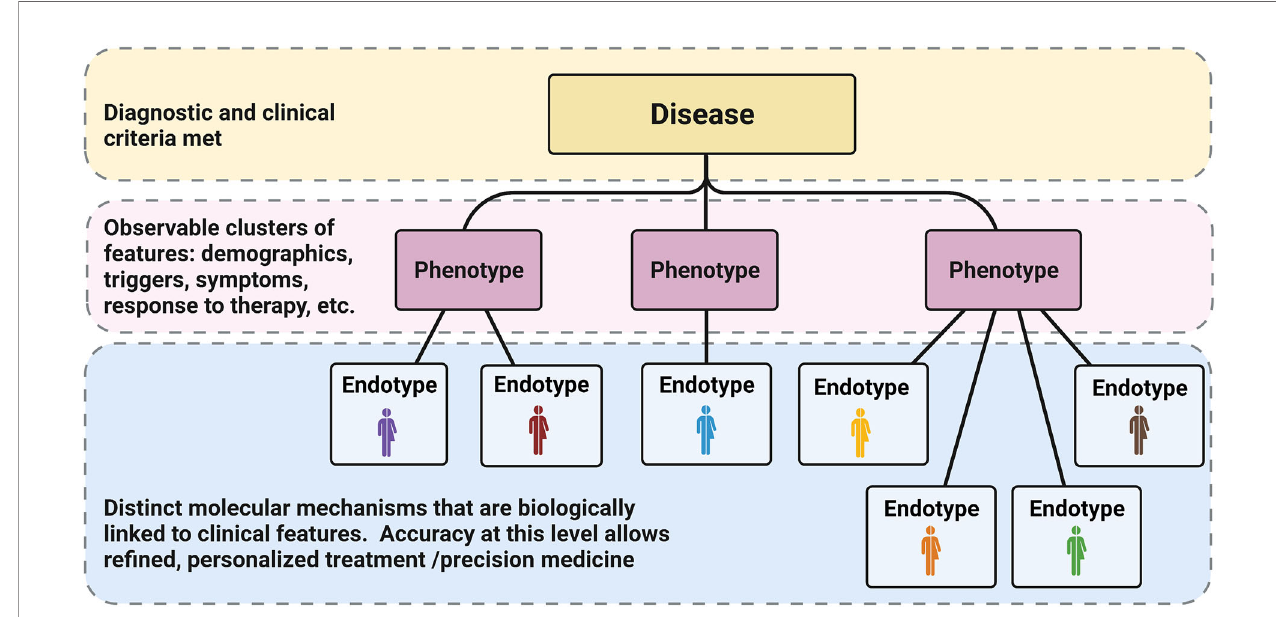
FIGURE 1 | Phenotypes vs Endotypes: Classically diagnosis at the disease level (yellow) depends on meeting speci fi c clinical criteria (usually linked to a speci fi c dysfunction or feature). Diseases have been subdivided over time into phenotypes based on other observable characteristics and patterns (pink). In the current age of re fi ned molecular analysis and big data, we have the opportunity to further characterize speci fi c molecular markers that are biologically linked to the levels above, de fi ning unique endotypes (blue). The accuracy of these distinctions will allow for speci fi c, targeted therapy and truly allow for precision medicine. Reproduced from